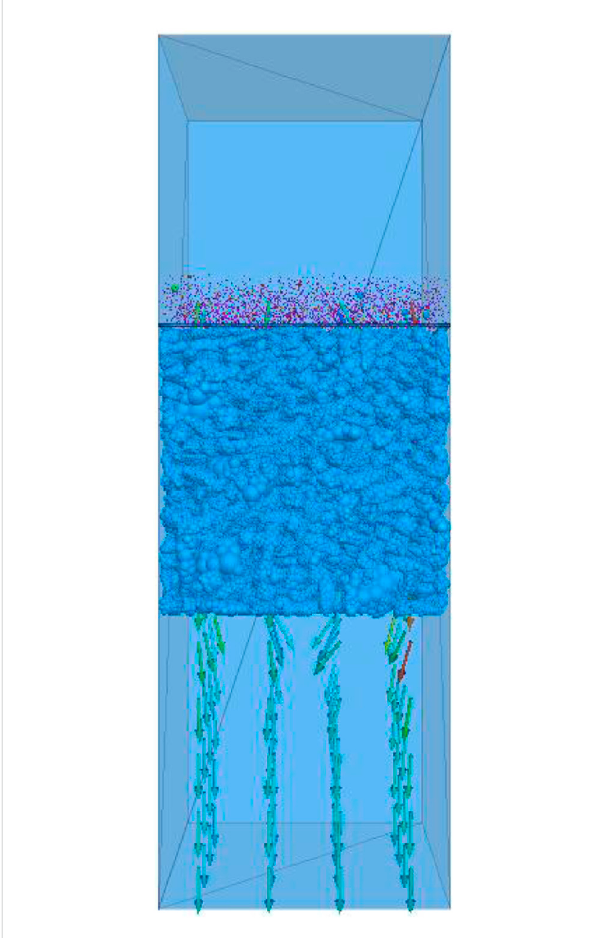
FIGURE 9 Simulatedcloggingtestofpermeablepavementundertheaction of gravity and running